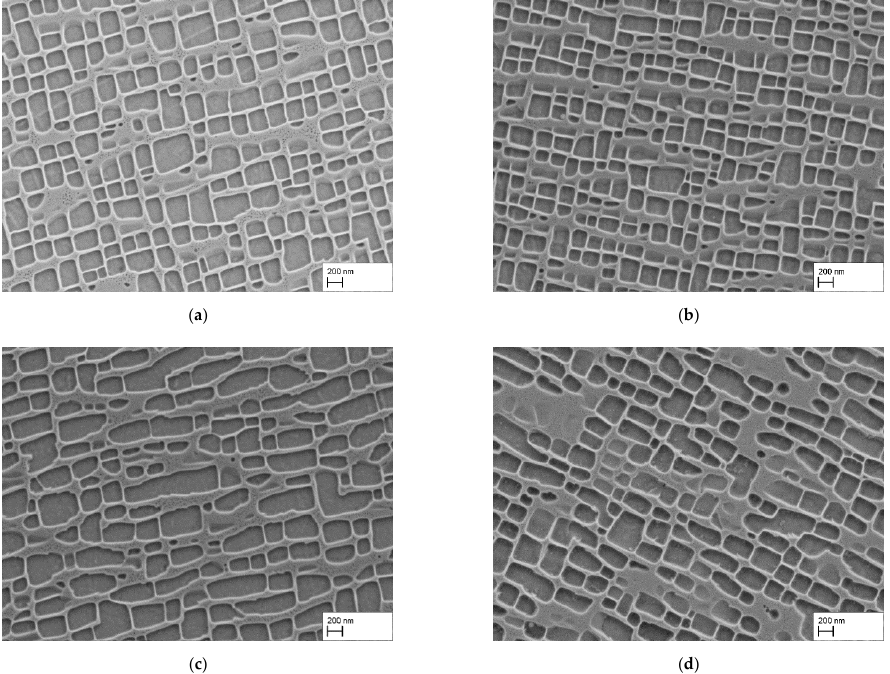
Figure 3. γ / γ′ -microstructure after homogenization and precipitation heat treatments: ( a ) HT/AC + 1080 °C/6 h/AC, ( b ) HT/AC + 1080 °C/4 h/AC, ( c ) HT/WQ + 1080 °C/6 h/AC, ( d ) HT/WQ + 1080 °C/4 h/AC. Table 4. γ′ -edge length and γ′ -volume fraction of the AC and WQ samples with additional heat treatment at 1080 °C.